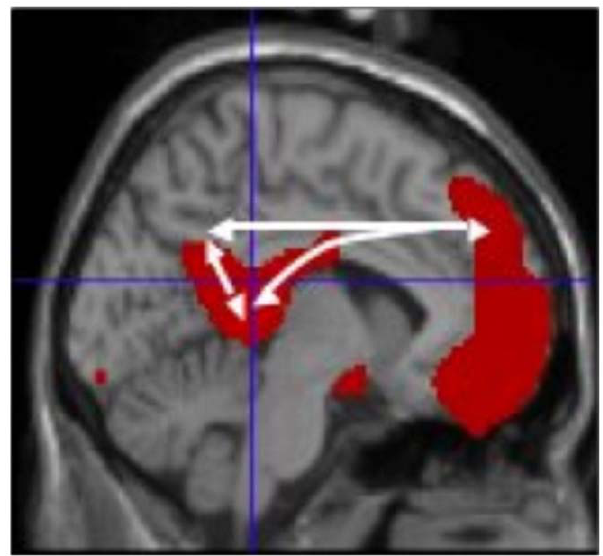
Figure 1. A paralimbic network of self-awareness. The network was identified in a previous PET study of hemodynamic paralimbic interactions elicited by self-awareness [12]). Talairach coordinates of anterior cingulate/medial prefrontal, posterior cingulate/medial parietal, and pulvinar thalami were measured for identification of targets for the MEG analysis used in the present study (0,59,40; 0, 2 50,28; and 0, 2 38,8, respectively).